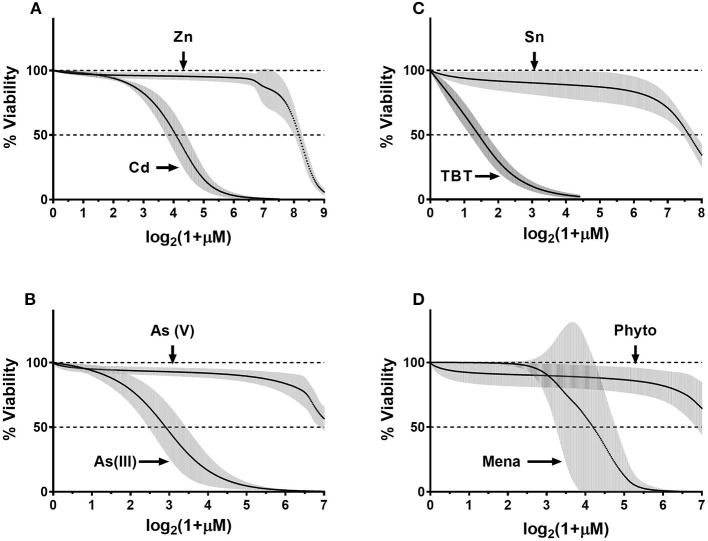
Composite fit-curve data for all donors. Data were fit as described in the Methods. We obtained a fit curve for each donor (n = 4) for each of the eight chemicals. Each donors' fit-curve has 300 data-points plotted on x-axis vs. % viability on the y-axis. Point-by-point mean values were calculated and plotted for four donors for each chemical (black dots) and 95% confidence interval (95%CI) was calculated for each data point (gray error bars).(A) CdCl2- ZnCl2; (B) As(III)-As(V); (C) TBT-SnCl2; (D) Menadione-Phytonadione.